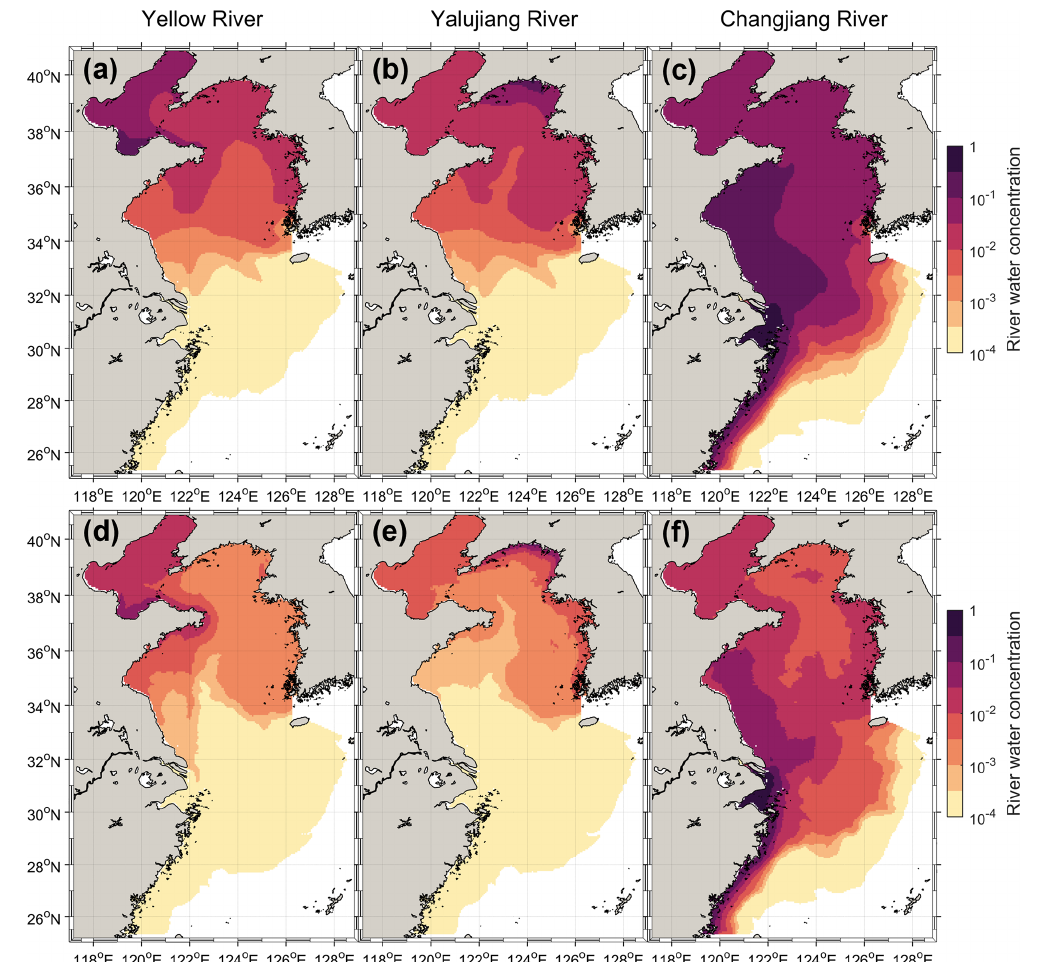
Figure 5. The annually and vertically averaged river water concentrations of the three rivers for the control run (a–c) and no-tide case (d–f) (the maps show the logarithmic distribution of the obtained river water concentrations).